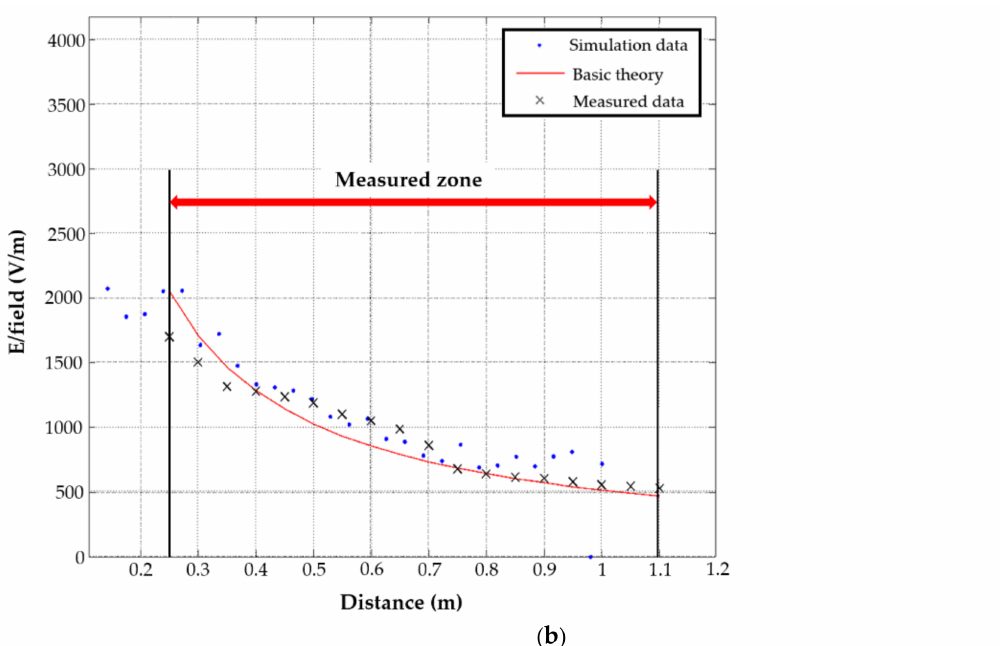
Figure 15. The results of the measurement, calculation and simulation of the E-field dependence on distance: ( a ) a full view of the Ey component dependence on the distance; ( b ) detailed view of the Ey component dependence on the distance.